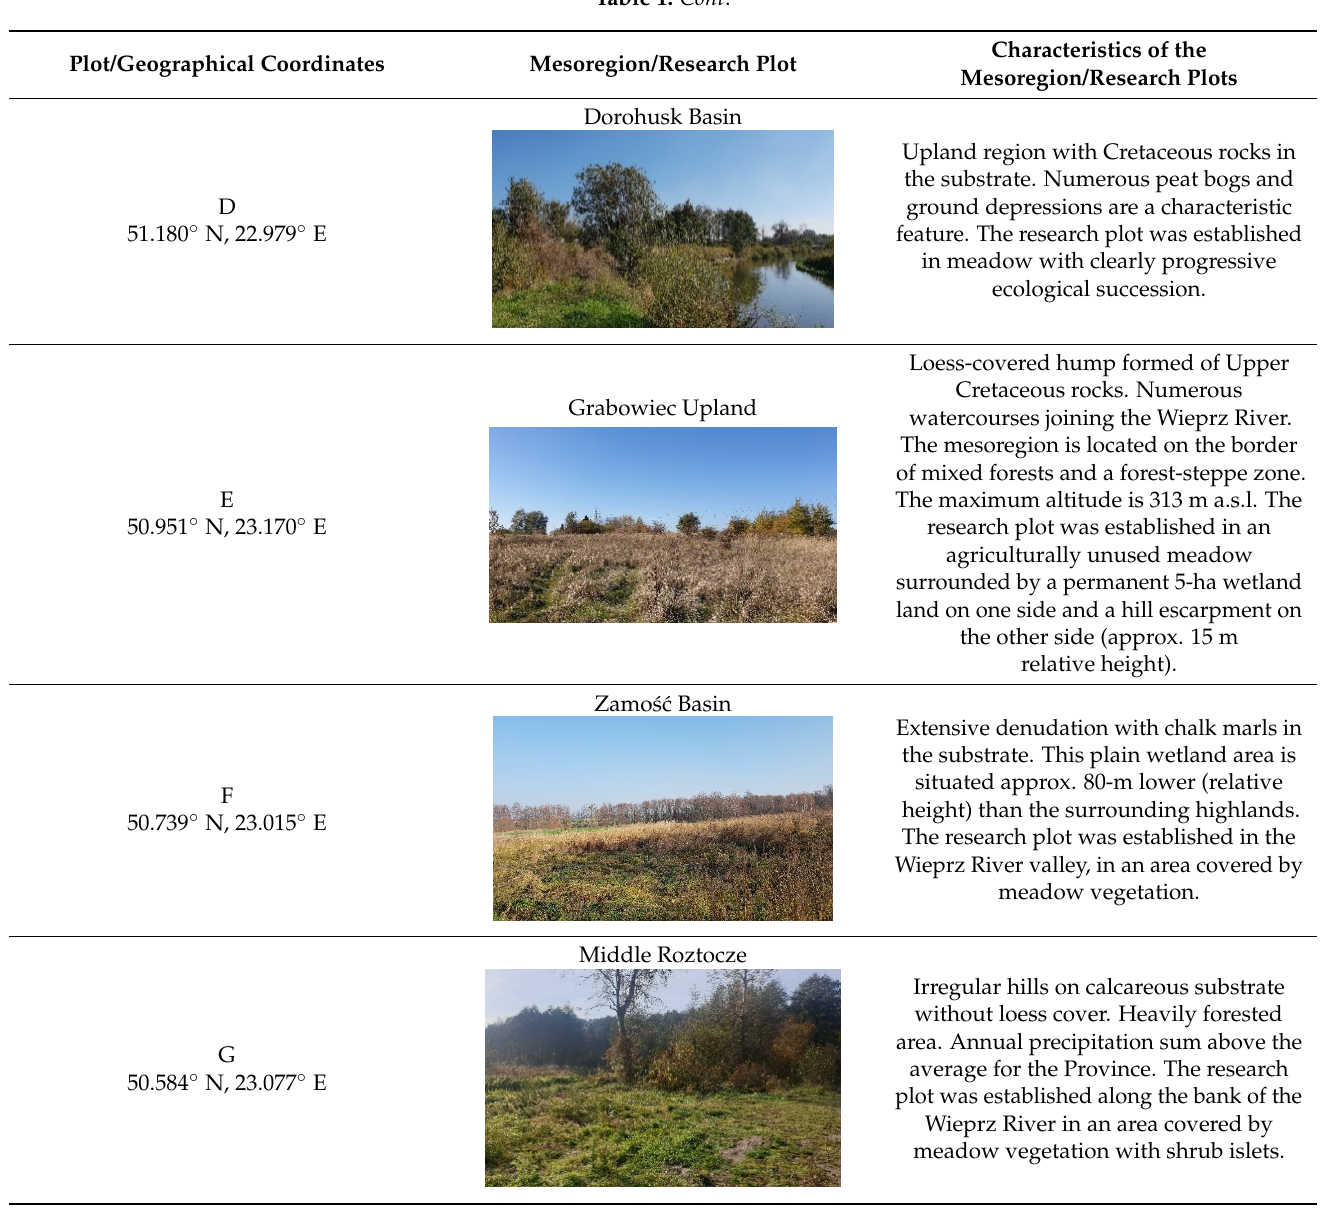
Figure 2. Location of the research plots (A – G). The Wieprz River is indicated by the blue line. Based on geoportal.gov.pl [26]. 2.2. Tick Surveillance The field studies were carried out between autumn 2018 and autumn 2019. Ticks were collected at regular two-week intervals from the end of February to June (spring period) and from September to mid-November (autumn period) (with modification in the